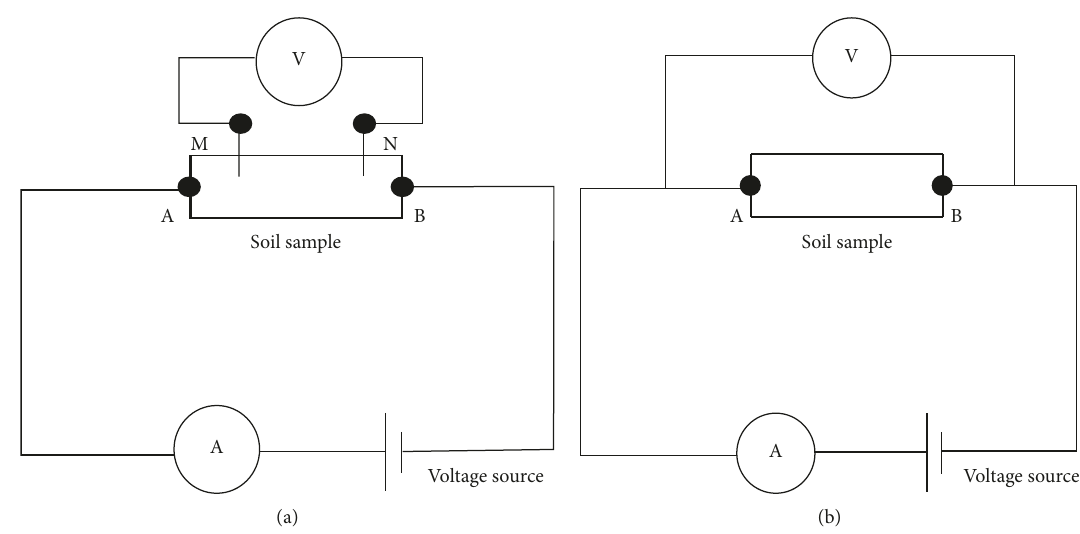
Figure 1: Resistivity test method for the soil samples: (a) the quadrupole method and (b) the dipole method.